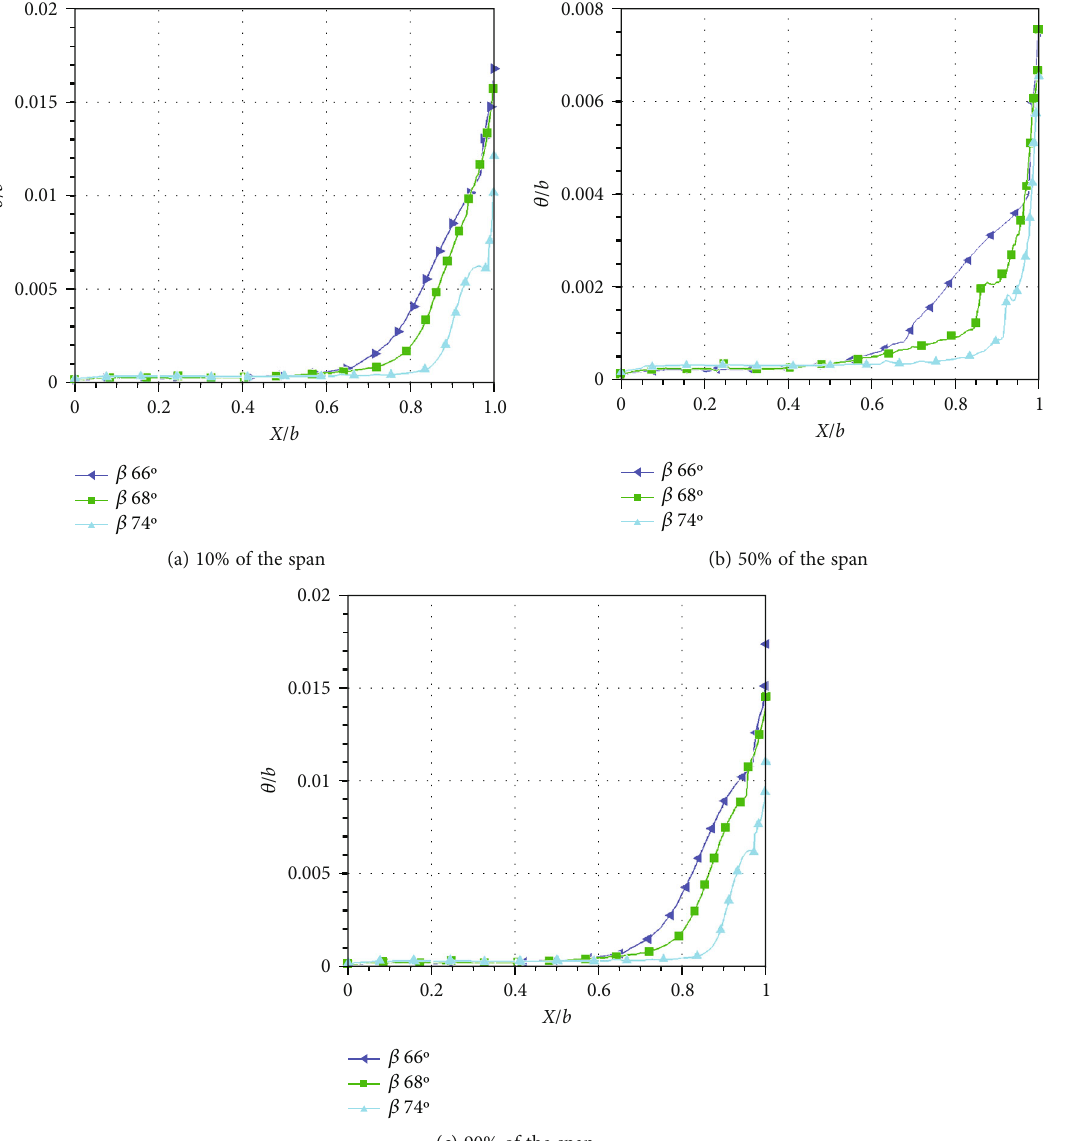
Figure 15: Comparison of boundary layer momentum thickness for di ff erent exit